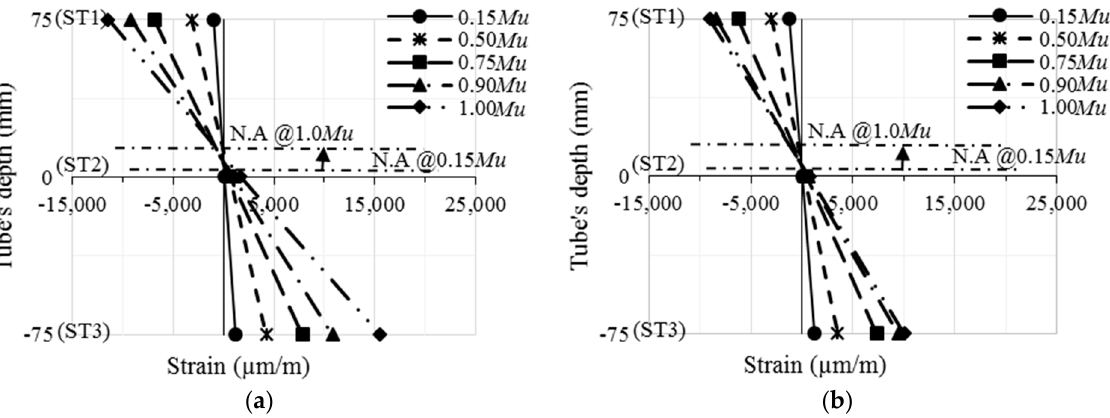
Figure 10. Typical strain distribution behavior along the RCFSST cross-section depth. ( a ) MC0 and ( b ) MC100.